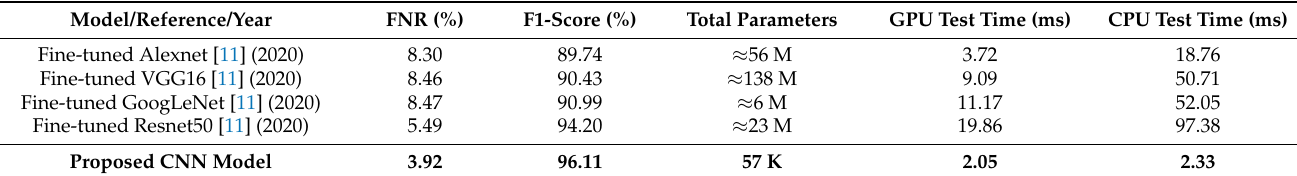
Table 9. Comparative analysis of the developed model and the baseline models on MMUTM